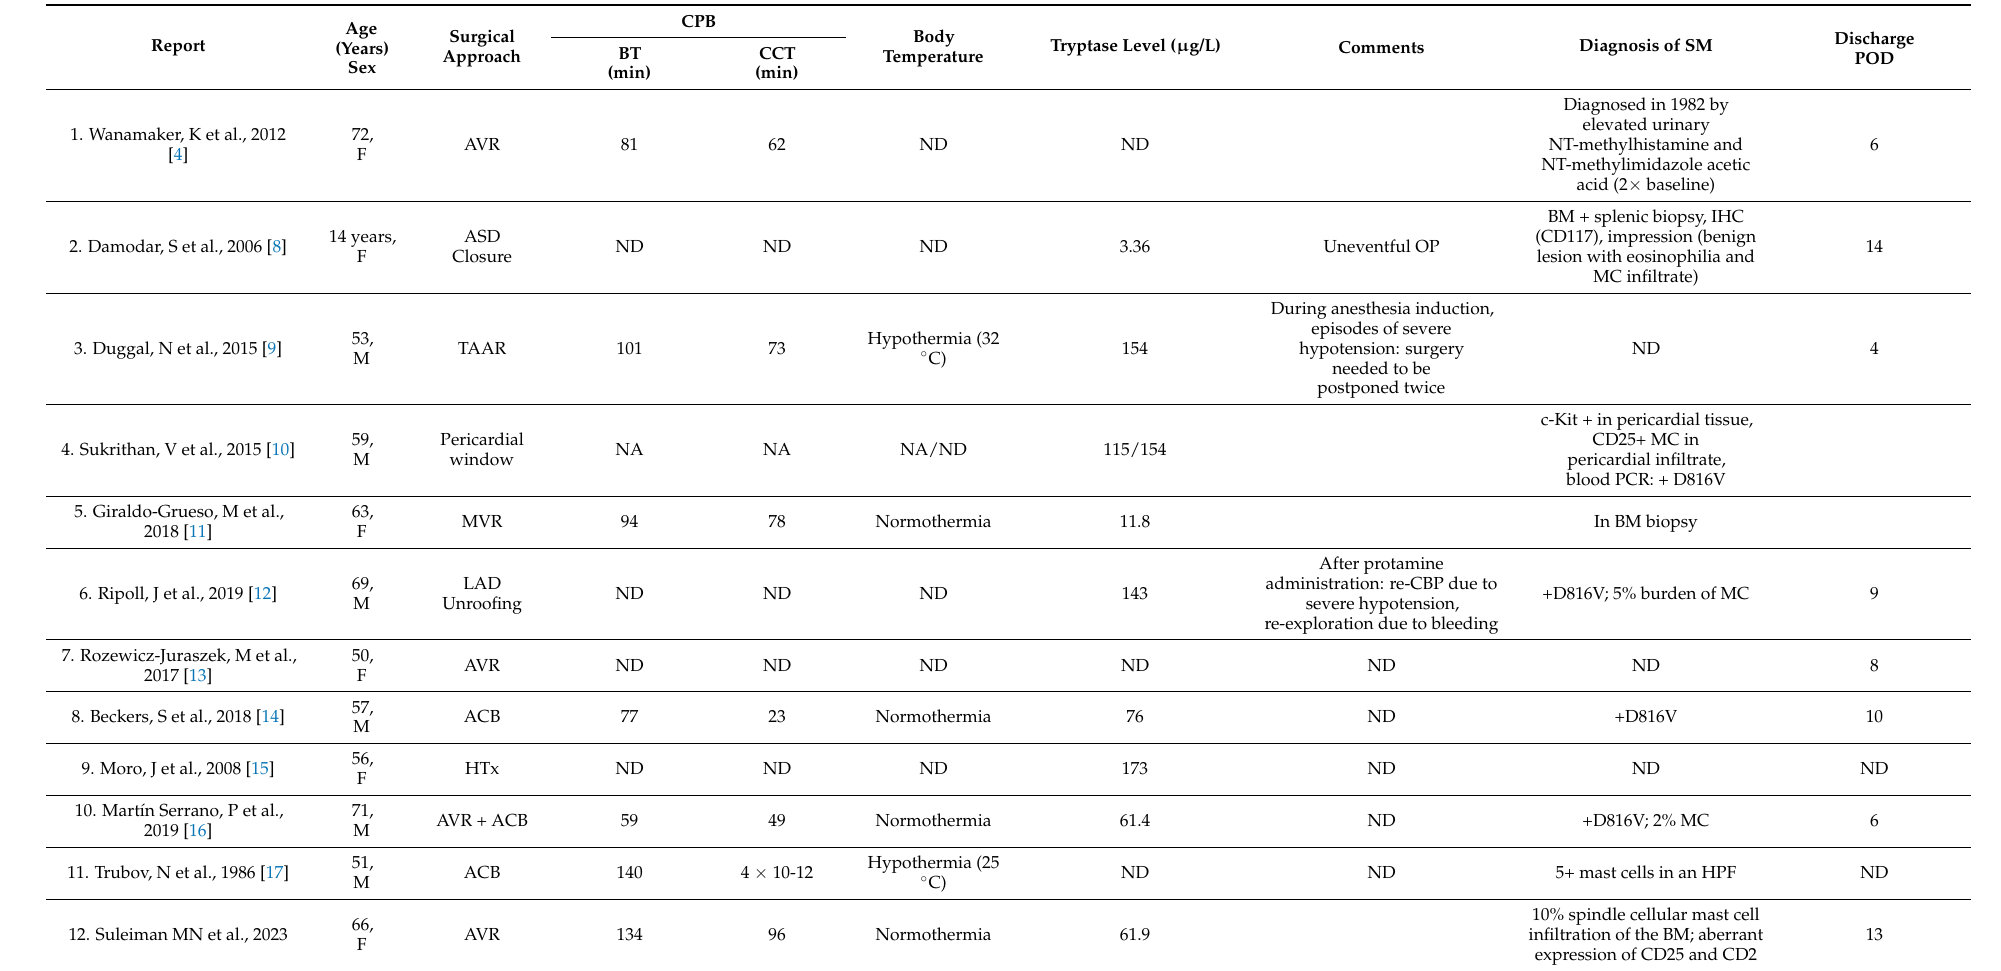
Table 1. Clinical characteristics of published